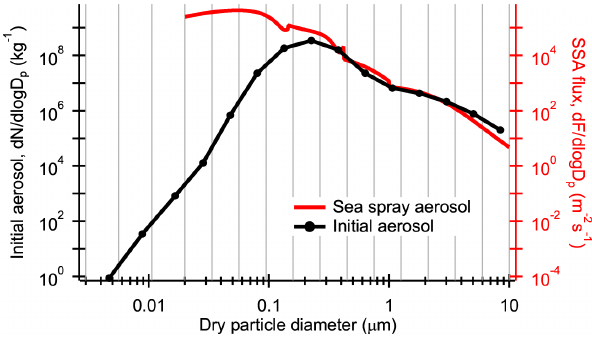
Figure 1. Initial aerosol size distribution for the ISDAC case (black line, left axis) and parameterized sea spray aerosol (SSA) emission flux for 6ms − 1 wind speed and 271.15K temperature (red line, right axis). Vertical grey lines represent aerosol dry size bin limits for